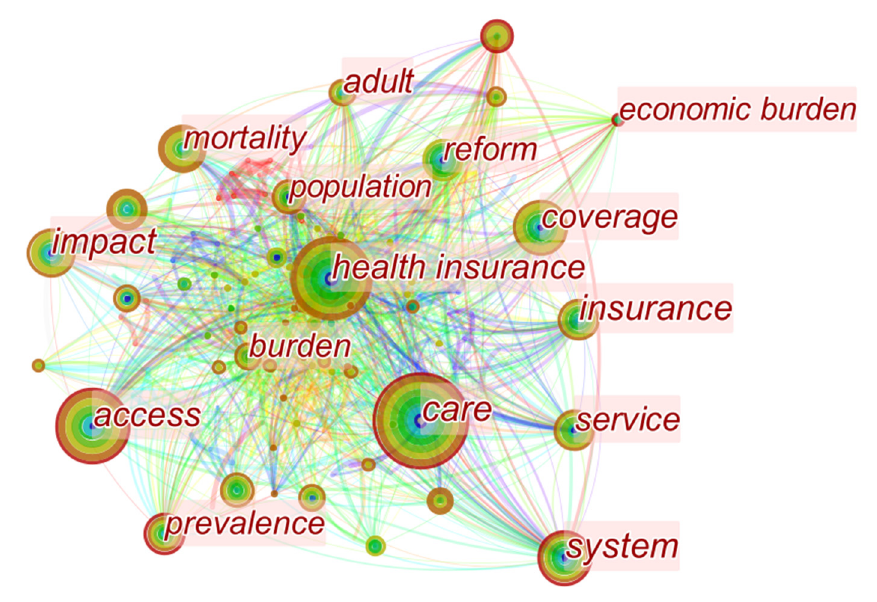
Figure 2. Visual mapping of the basic health insurance research on the Web of Science.